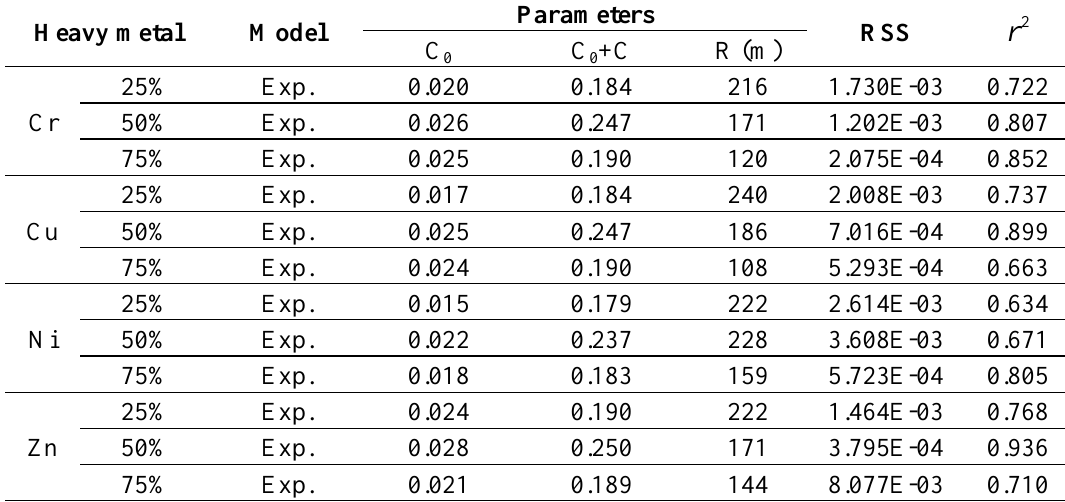
Table 3. Indicator variogram models for the 25th, 50th, and 75th percentiles of heavy metals in 1,082